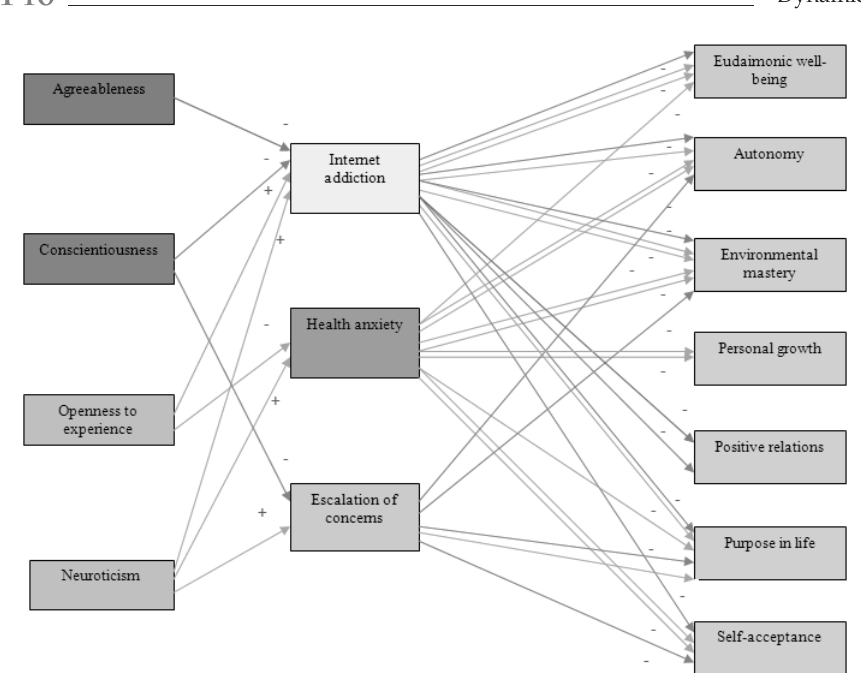
Fig. 3. Graphic model of the mediated in (cid:223) uence of personal traits on eudaimonic and psychological well-being with mediators Internet addiction, anxiety aroused by online health information seeking, escalation and persistence of health concerns Source: Own